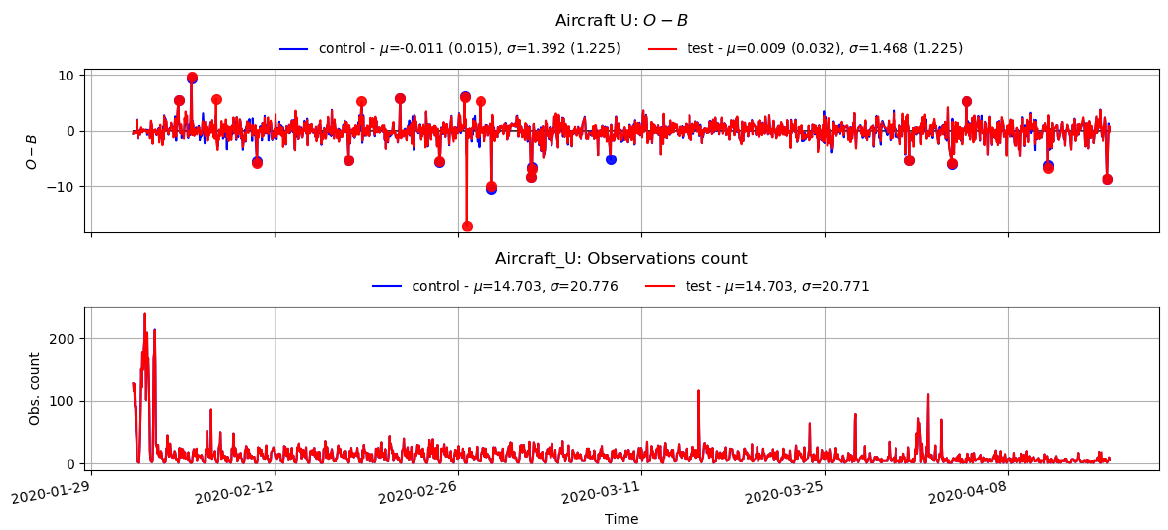
Figure 7. Time series plot of O-B (top), and the number of observations for Aircraft-U components from the control and test.